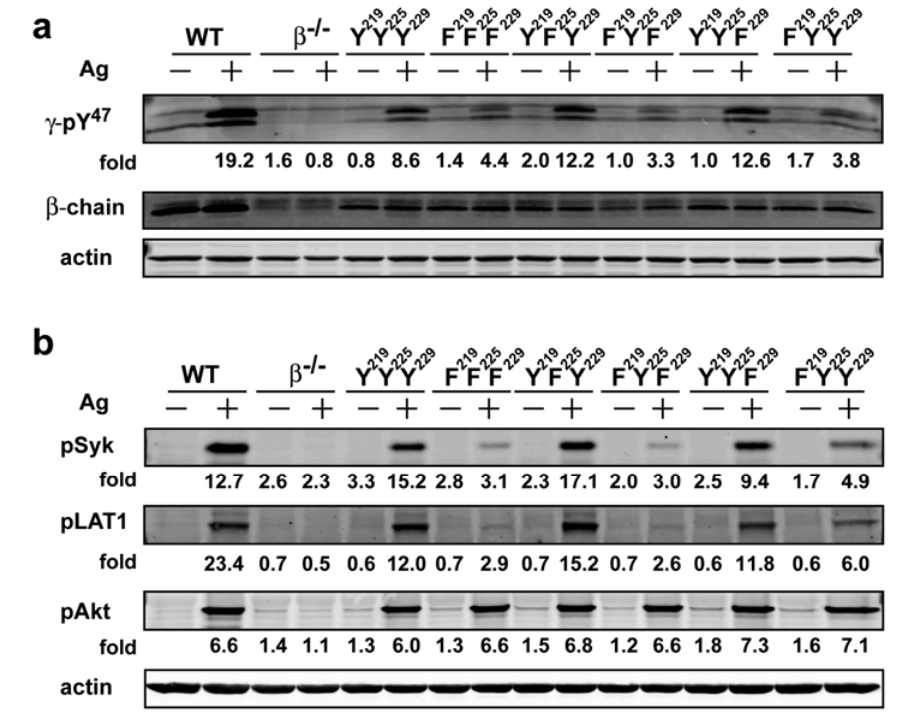
Figure 3. The Fc ε RI β Y 219 regulates phosphorylation of Fc ε RI γ ITAM Y 47 and proximal signaling molecules. Whole cell lysates from WT cells were resolved under reducing conditions. ( a ) Immunoblots were probed with γ -pY 47 antibody. ( b ) Anti-phosphoSyk antibody (Y 519/520 ), anti-phospho LAT1 antibody (Y 191 ), and anti-phosphoAkt antibody (T 308 ) were used to detect site specific phosphorylation. Fold induction was calculated by densitometry and normalized to the respective protein or to